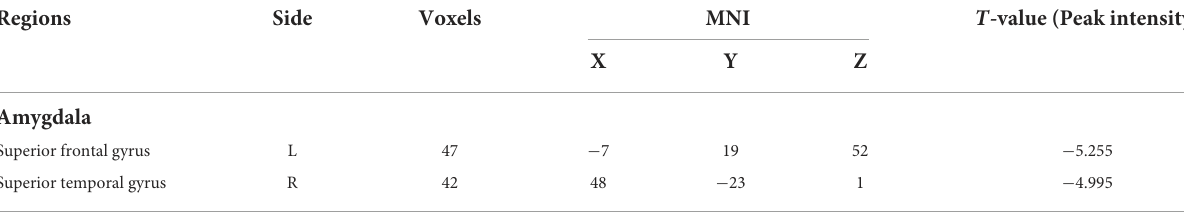
TABLE 2 Comparison of FC between post-acupuncture in subjective tinnitus and healthy control. Regions